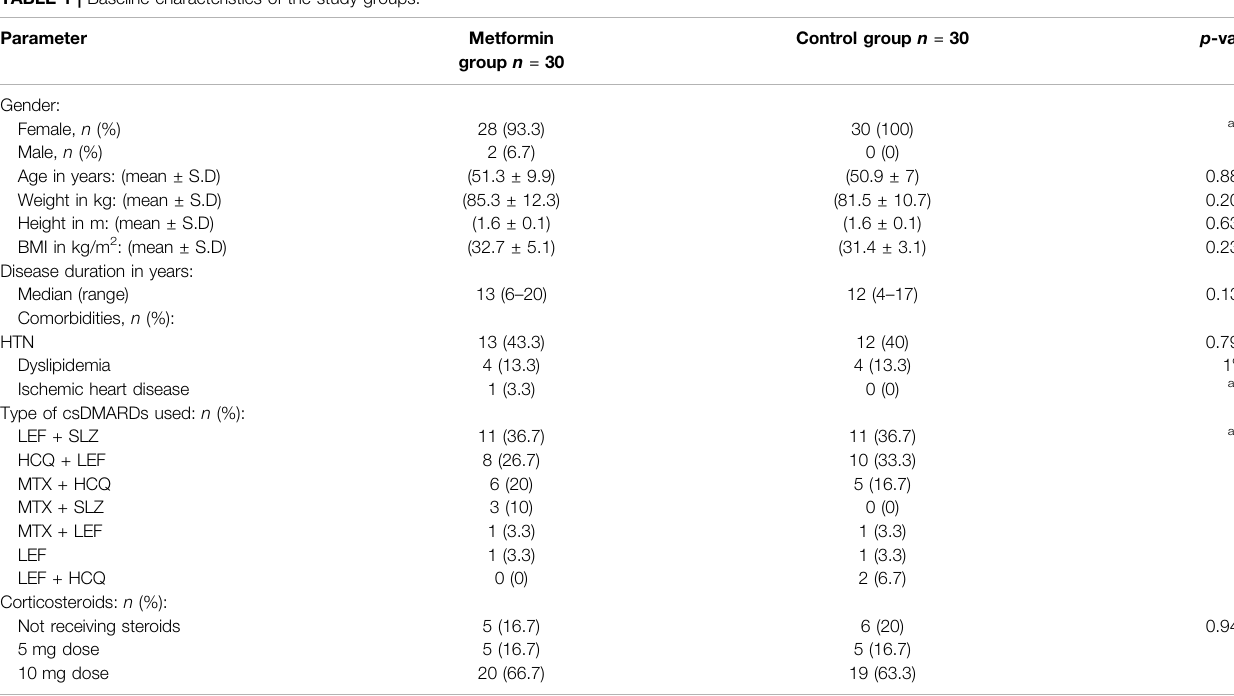
TABLE 1 | Baseline characteristics of the study